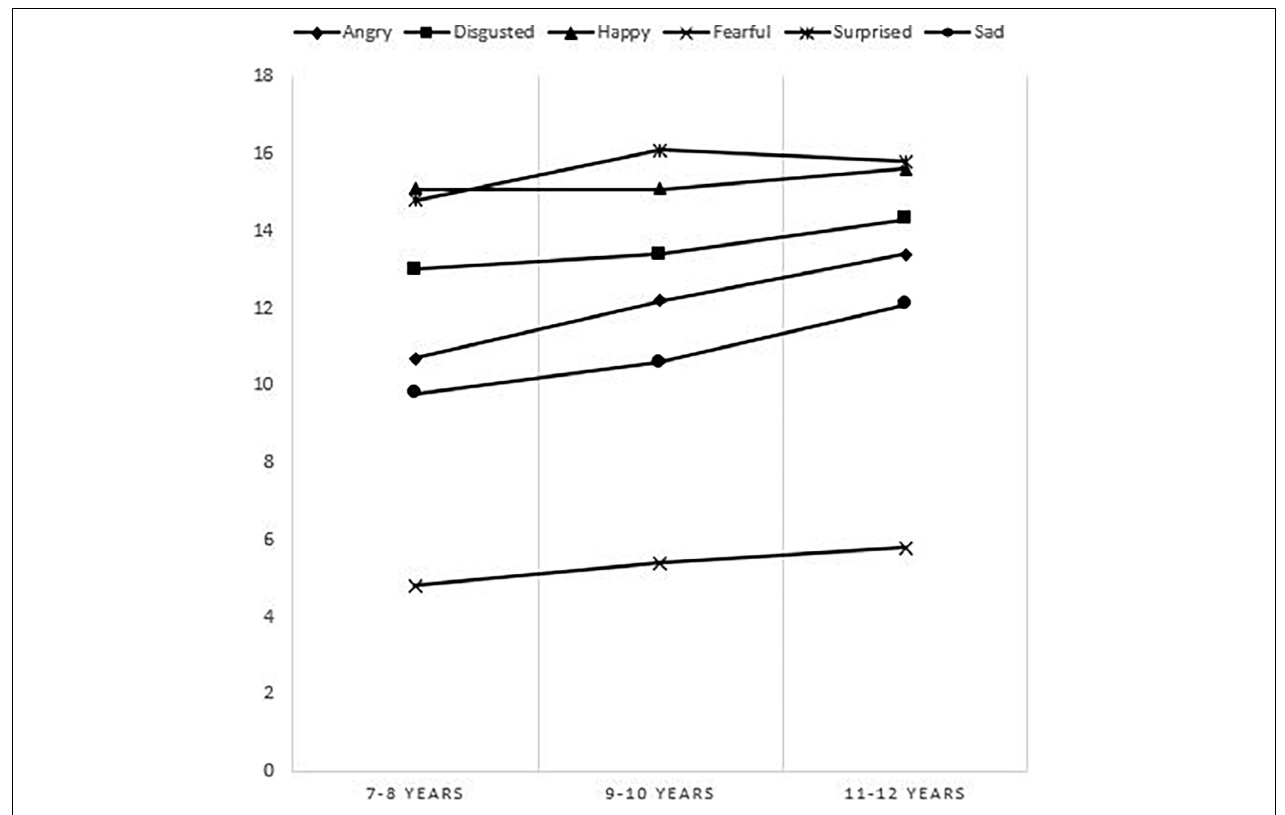
FIGURE 3 | Mean scores per emotion according to age on the static subtest. TABLE 3 | Pearson’s correlation between the emotions and age on the two subtests of the REF: TTC. Emotion Happiness Anger Fear Sadness Disgust Surprise Static subtest Age p : 0.53 P < 10 − 3 r : 0.33 p : 0.6 p : 0.1 Dynamic subtest Age p : 0.5 p : 0.03 r : 0.21 P values in bold represent significance threshold; r values in bold represent Pearson coefficient.